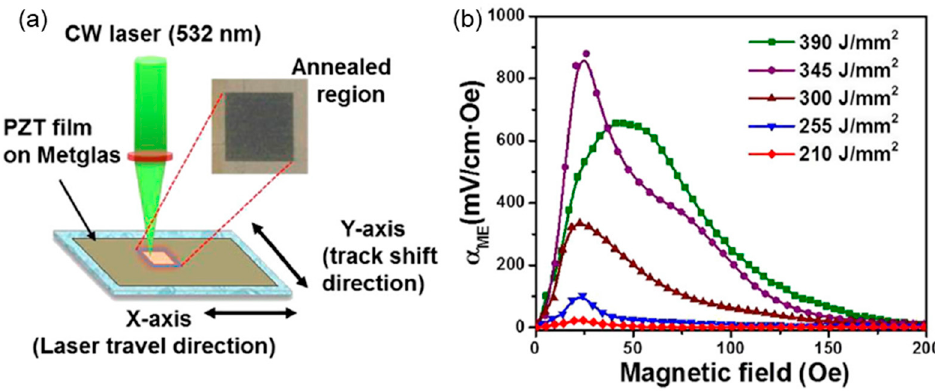
Figure 12. ( a ) Schematic of laser annealing of PZT/Metglas. ( b ) Variation of magnetoelectric (ME) voltage coefficient ( α ME ) as a function of H dc at a fixed AC magnetic field of 1 Oe at f = 1 kHz for laser annealed PZT/Metglas [30]. © Copyright 2016, J. Am. Ceram. Soc.